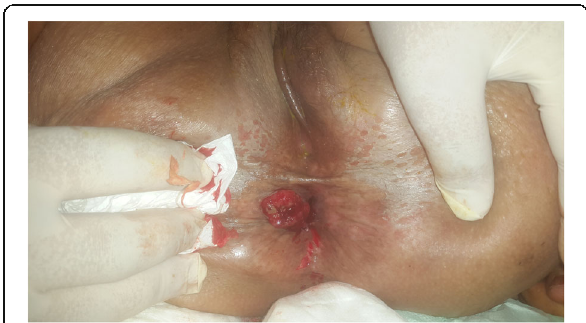
Fig. 2 A budding lesion 2 cm on the right of the anal verge, developing from the perianal skin, without continuity with the coloanal